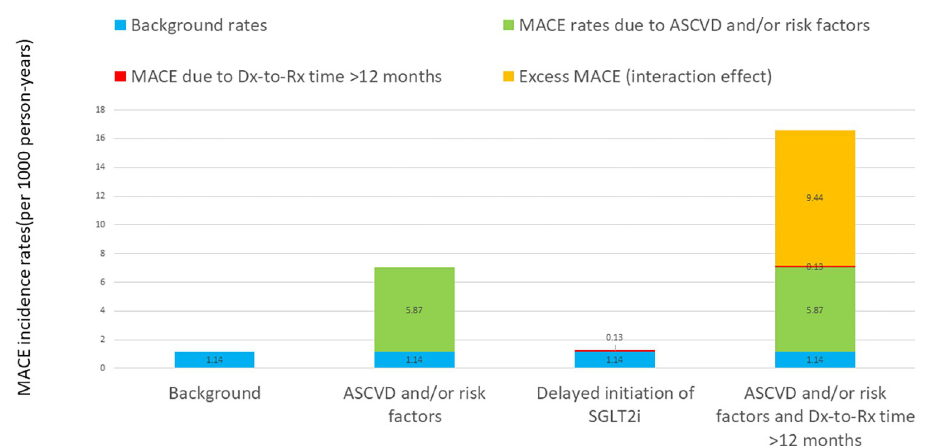
Fig 2. Quantification of interaction effect of ASCVD (and/or risk factors) � delayed initiation of SGLT2i.